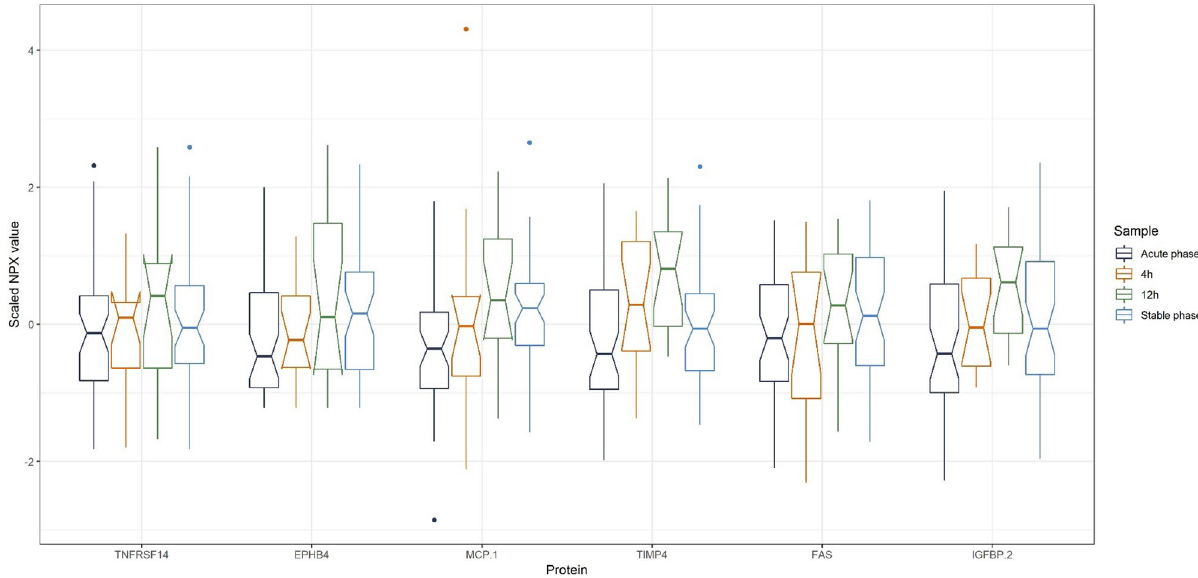
Figure 4. Box plots for the time-points acute phase, 4 h, 12 h, and stable phase for the six proteins in clustering group 1. Notches determines the 95% confidence interval for the median value. On the y-axis scaled NPX values are shown. The scaled NPX values cannot be compared directly between proteins, but only between measurements of the same protein. This figure was made with the R software package called ggplot2, version